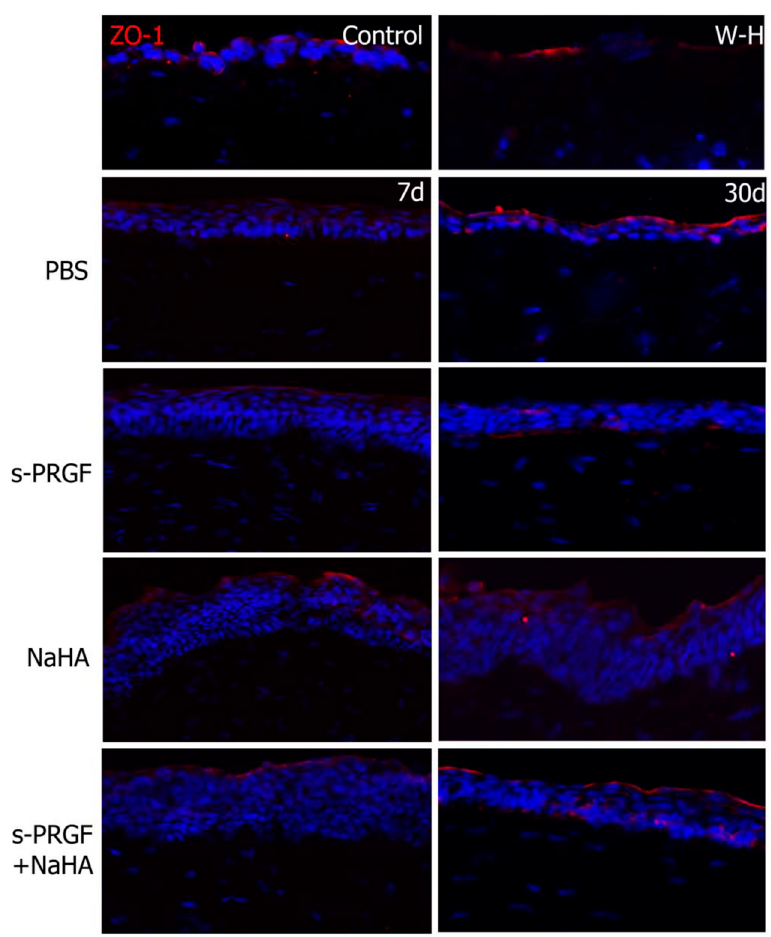
Figure 8. Fluorescent immunostaining for ZO-1 on rabbit central corneas after healing of the epithelial defect. Rabbit corneas were treated with s-PRGF, s-PRGF and NaHA, NaHA, or PBS (as a control), and were processed 7 and 30 days after cornea surgery. Control corresponds to a healthy rabbit cornea with no surgery. The W-H image shows a cornea processed 48 h after surgery without complete re-epithelialization. Magnification 200×.